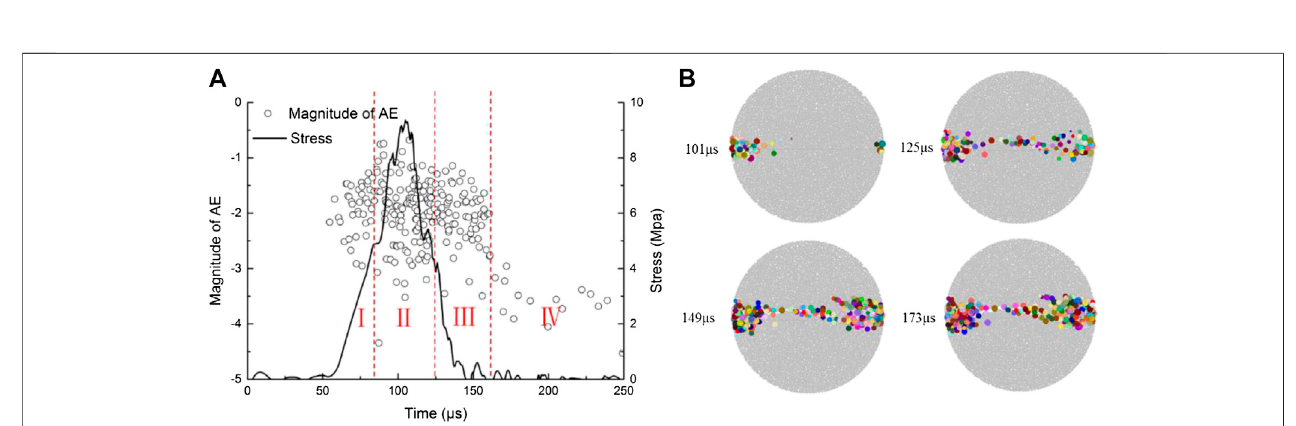
FIGURE 15 | (A) The magnitude of AE and stress on rock changing with time. (B) The AE location in this